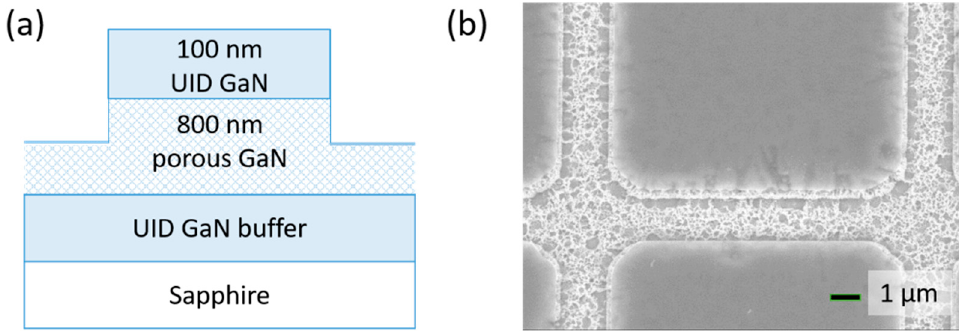
Figure 1. ( a ) Schematic structure of the GaN-on-porous-GaN pseudo-substrate. ( b ) Top view scanning electron microscopy image showing the tiles.